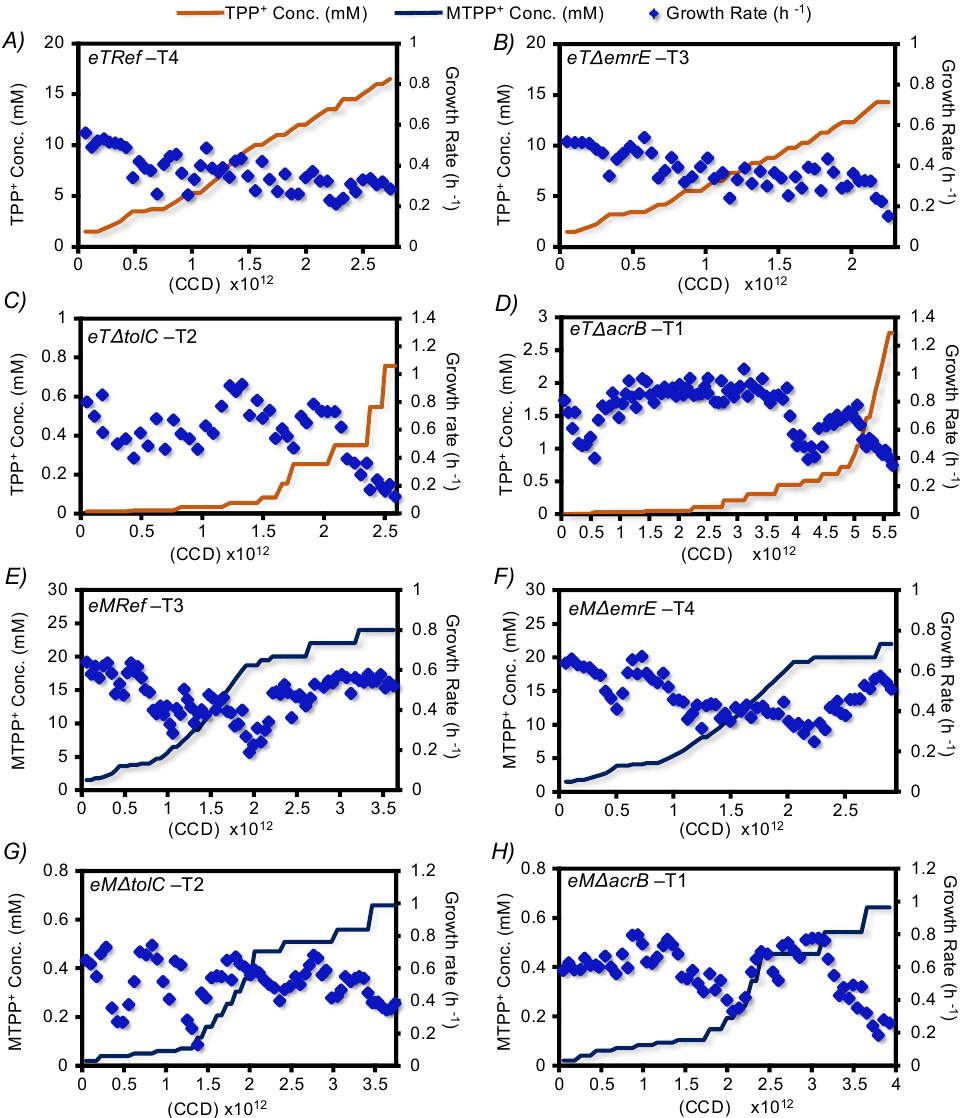
Figure 1. The full fitness trajectories of strains evolved independently under increasing concentrations of TPP + and MTPP + . Depicted are the full fitness trajectories and the cation concentrations versus cumulative cell divisions (CCDs) experienced by a representative TALE lineage (abbreviated to T and the number indicate the replicate identifier) of each represented population. Each dot (bright blue diamonds) represents a calculated growth rate value of cells that were growing separately under increasing concentrations of TPP + (orange lines, panel ( A – D )), and MTPP + (dark blue lines, panel ( E – H )).